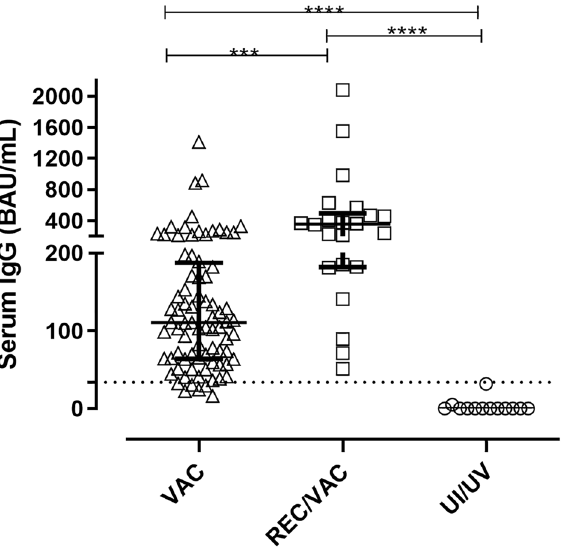
Figure 1. Serum IgG antibodies against SARS-CoV-2 spike protein. Serum from COVID-19 vaccinated (VAC) (n = 80; triangles) patients, those who were recovered from COVID-19 and vaccinated (REC/VAC) (n = 22; squares) and negative control (UI/UV) individuals (n = 13; circles) were analysed to measure the IgG antibodies anti-SARS-CoV-2 S1 and S2 proteins. Scatter plots show lines at the median with interquartile ranges. The dashed line represents the cut-off value for the test (33.8 BAU/mL). One-way ANOVA and the nonparametric Kruskal–Wallis test were used to compare the study groups. Asterisks denote statistical significance between the groups (*** p < 0.001; **** p <